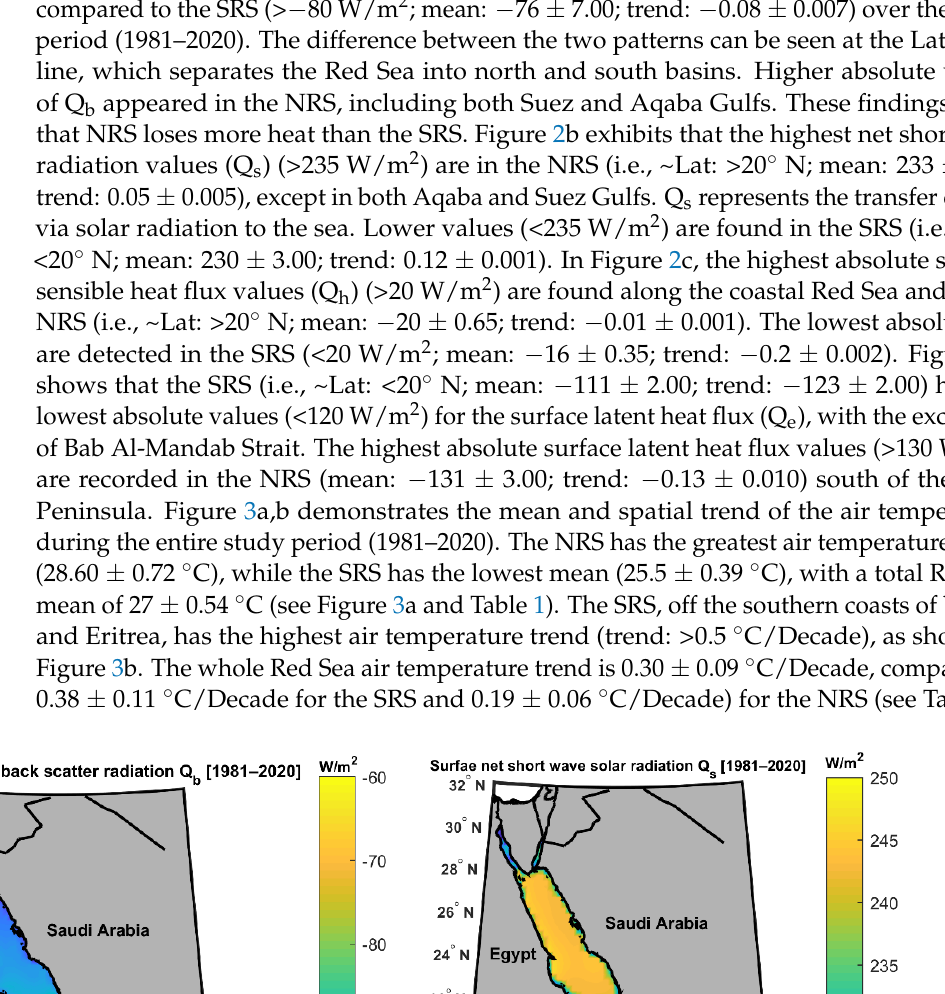
Figure 2. Spatial distribution for the surface net heat flux components (W/m 2 ) in the Red Sea over the study period (1981– 2020): ( a ) surface net longwave backscatter radiation (Q b ); ( b ) surface net shortwave solar radiation (Q s ); ( c ) surface sensible heat flux (Q h ); ( d ) surface latent heat flux (Q e ).